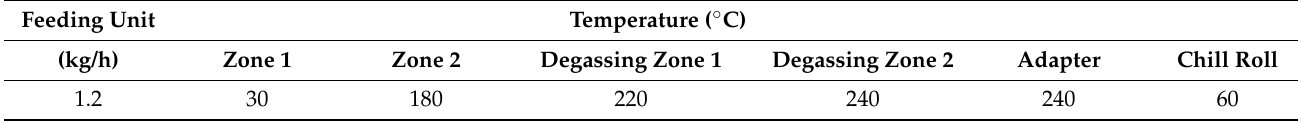
Table 3. Machine data for LDPE cast film